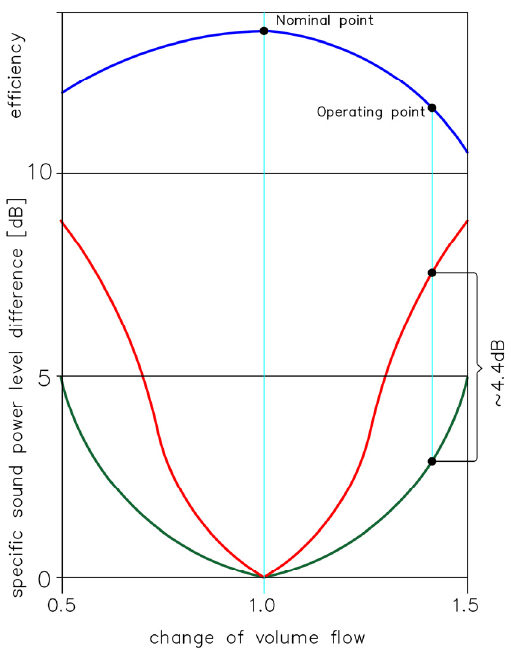
Figure 7. Characteristics of an example fan, where: efficiency—blue line, specific sound power level difference at nominal operating point—green line, and change in specific sound power level difference as a function of change in volume flow—red line. Table 2. Publications and activities related to the reduction of noise generated by fans.